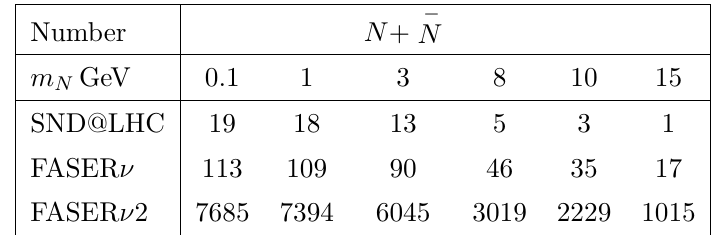
¯ N to be detected by FASER ν and SND@LHC during as shown in the second N